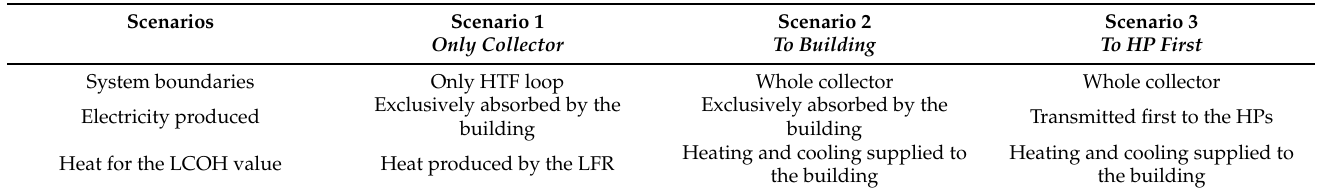
Table 4. Scenarios for LCOH calculation.